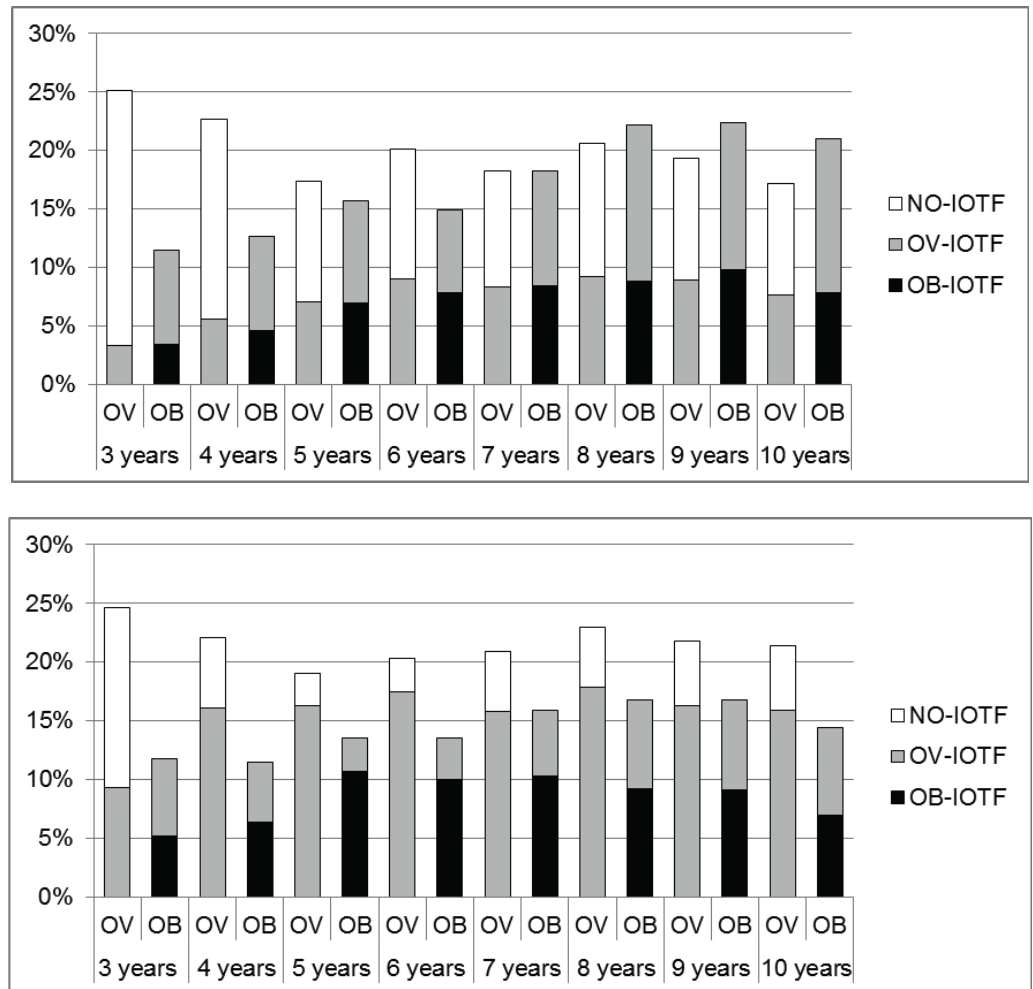
Figure 1. Prevalence of overweight (OV) and obesity (OB) as function of the WHO criterion considering the disagreement of the WHO vs. the IOTF criteria by sex (boys, over; girls, below) and age (OB-IOTF, obesity; OV-IOTF, overweight; NO-IOTF, non-